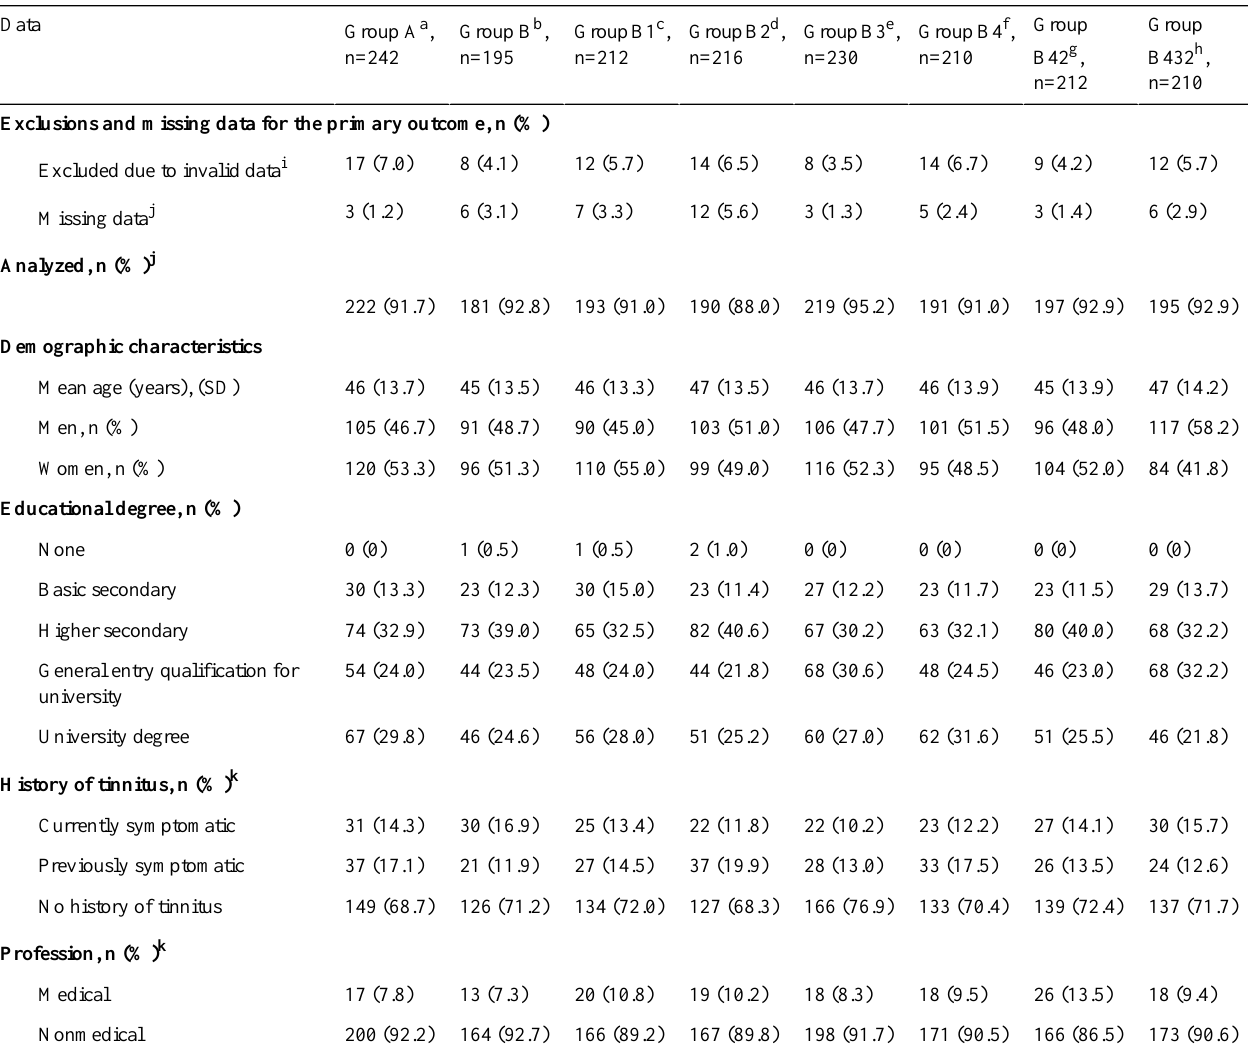
Table 2. Sociodemographic characteristics of the participants.